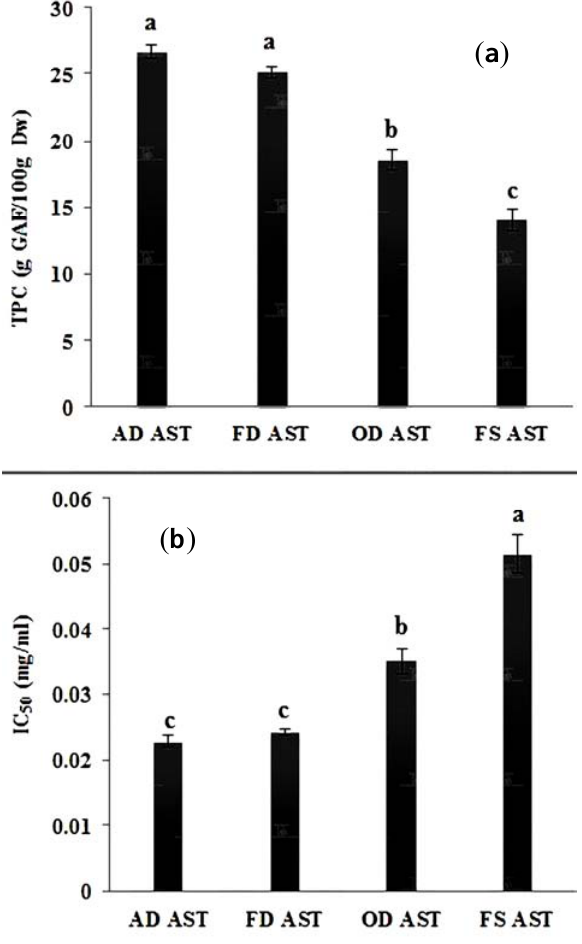
Figure 2. ( a ) Evaluation of the TPC variation after three months of storage of processed C. caudatus samples; ( b ) Evaluation of the IC difference after three months of storage of 50 processed C. caudatus samples. AD AST air-dried sample after storage time, FD AST freeze-dried sample after storage time, OD AST oven-dried sample after storage time and FS AST fresh sample after storage time. a–c Each different small letters above columns indicates a statistically significant ( p < 0.05; n = 6)